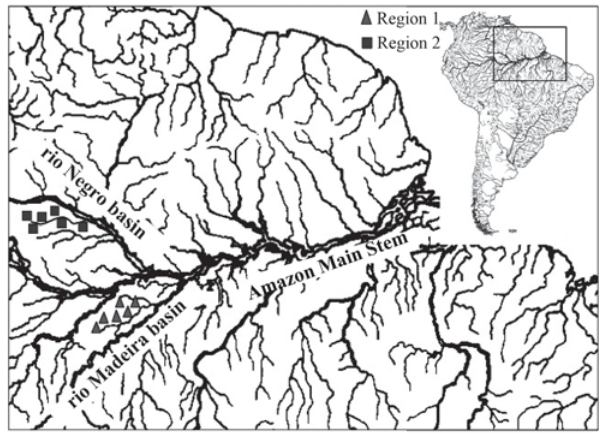
Fig. 2. Collecting regions in two cyclically flooding drainages in the rio Amazon basin. Region 1, the Igapó-Açu region, a blackwater tributary complex of the rio Madeira, provided specimens of C. temensis and C. monoculus . Region 2, the rio Caures, a blackwater tributary of the rio Negro, provided specimens of C. temensis and C.